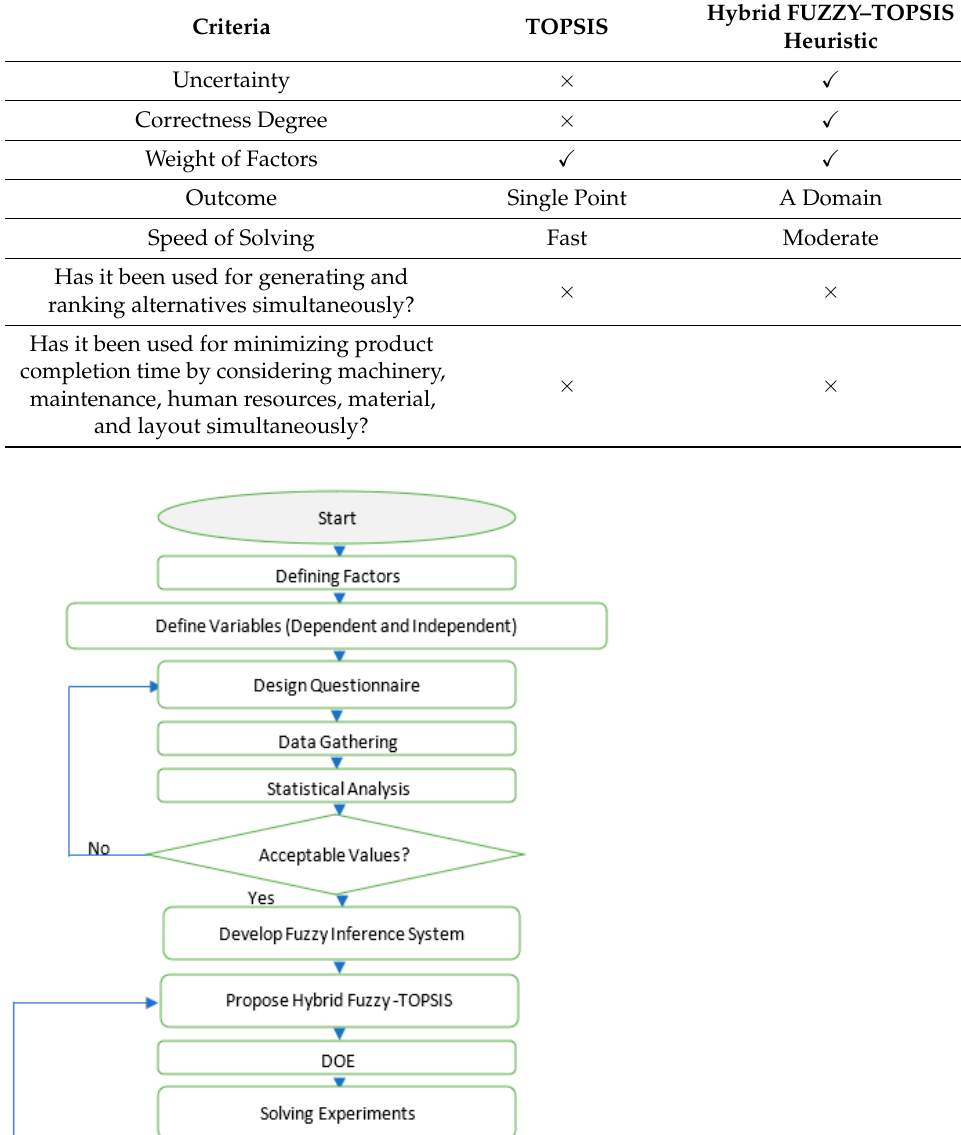
Table 2. Comparing classic TOPSIS with the proposed hybrid fuzzy-based heuristic.